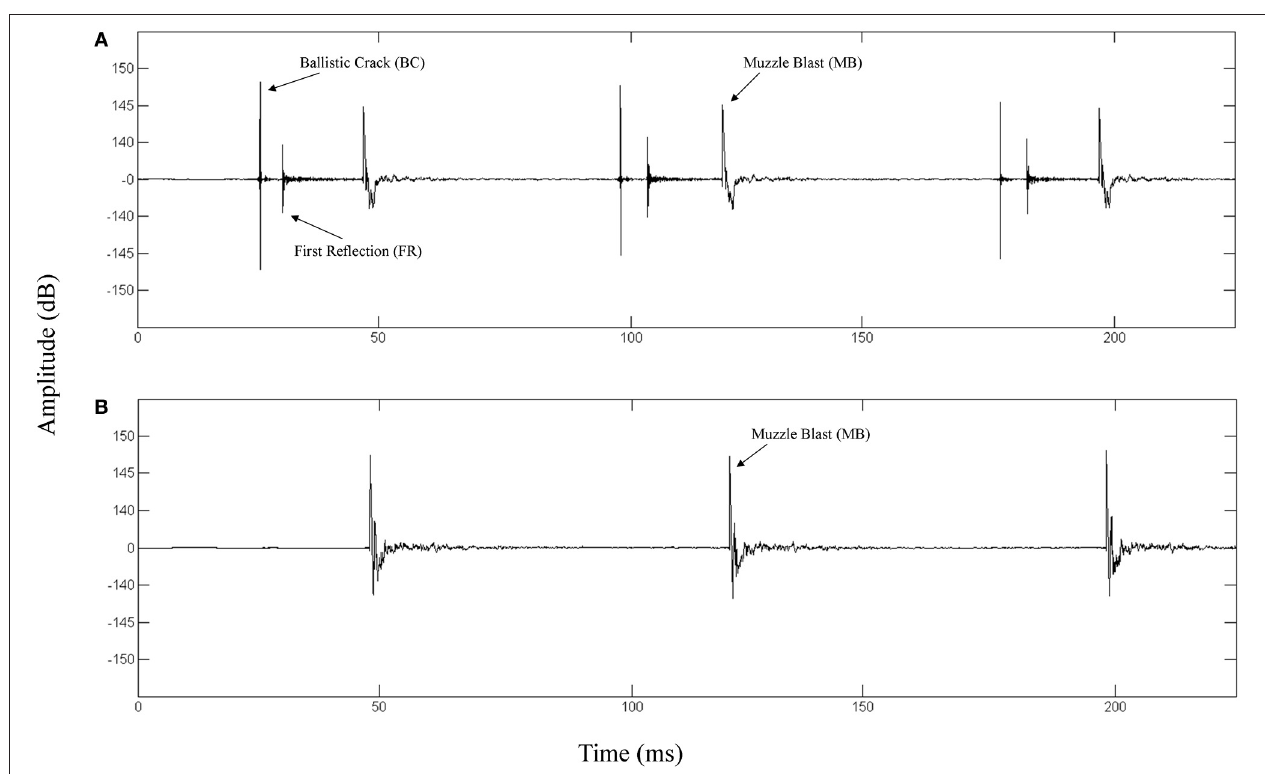
blast are labeled. (B) Waveform of a 3-round burst of fire for a M4 carbine recorded 16m perpendicular to the left of the shooter target line (90 ◦ incidence). The muzzle blast is